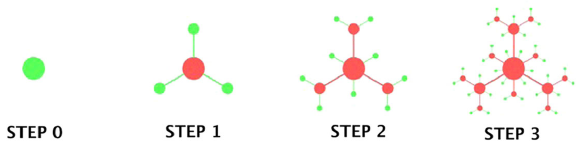
FIG. 7. The building of our fractal with a -fold, step-by-step from left to right. Here the parameter α ¼ 3